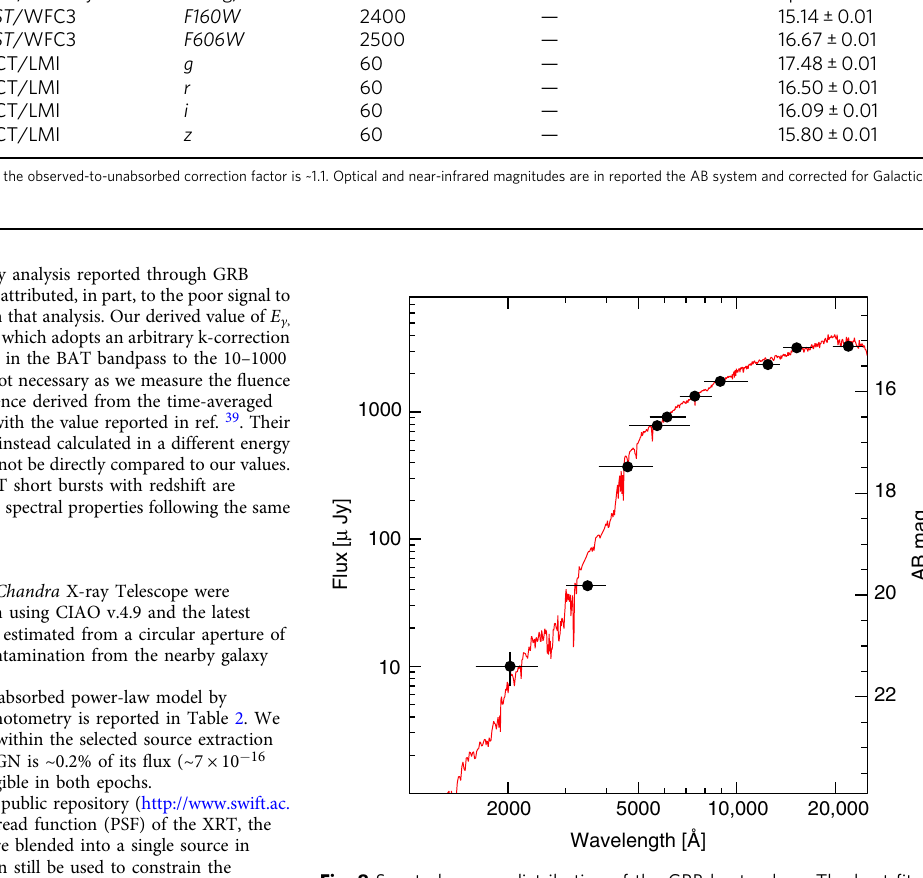
Fig. 8 Spectral energy distribution of the GRB host galaxy. The best fi t model is shown by the solid